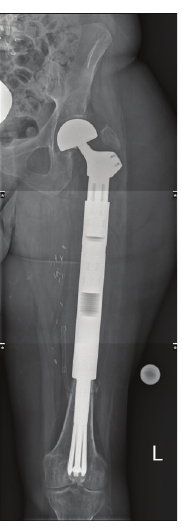
Figure 3: Postoperative X-ray of the implanted spreading